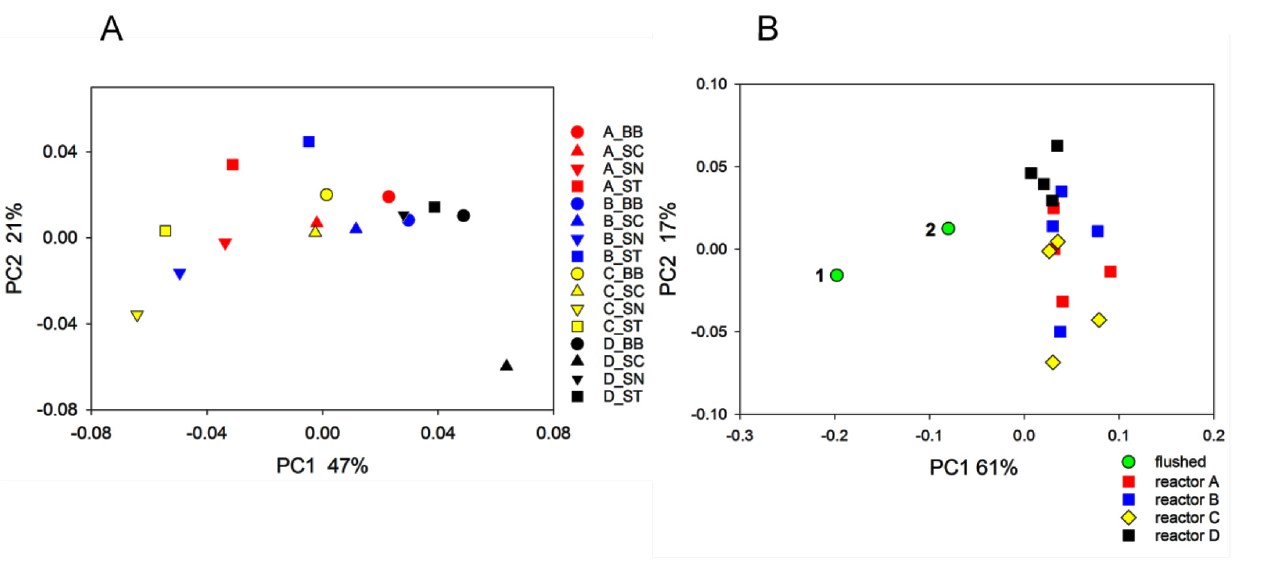
Fig 4. Principal Coordinate Analysis of reactor biofilms grown from flushed Bethlehem distribution system biofilms. A, 16 biofilm samples are represented according to biofilm recovery method (symbol) and reactor (color). The key indicates reactor_method, where circle = bead beating (BB), triangle up = scraping (SC), triangle down = sonication (SN), and square = stomaching (ST). B, PCoA illustrating distances between flushed (n = 2) and corresponding reactor biofilms. Flushed biofilm 1 indicated in plot B was seeded into the reactors. Sample 2 is a second sample flushed from the same hydrant a few seconds later. Distances between symbols are indicative of phylogenetic (Unifrac) distance. Percent variation explained by each axis is indicated.